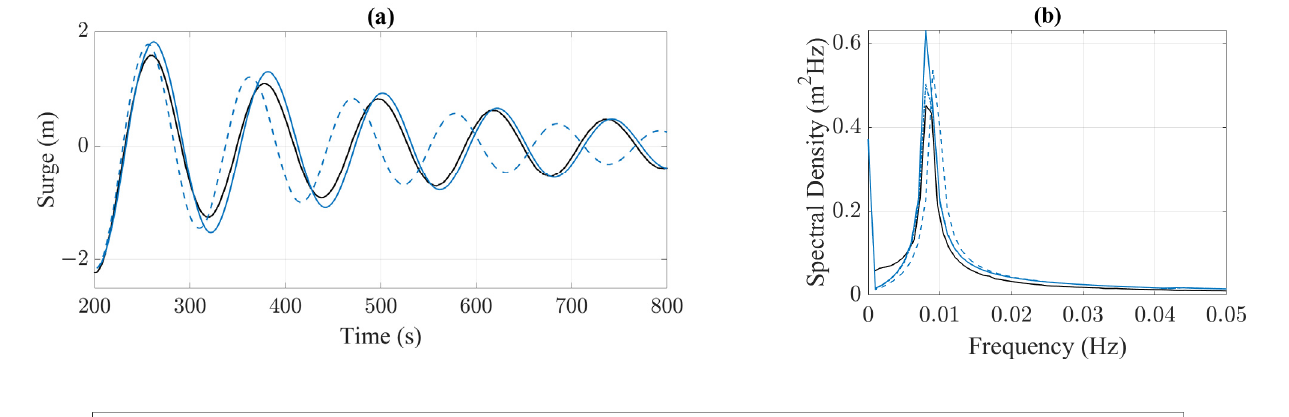
Figure 7. ( a ) Time series of surge displacement of free decay tests and ( b ) the corresponding spectral density plot. Table 4. Surge natural period, damping particulars, and mooring pre-tension.